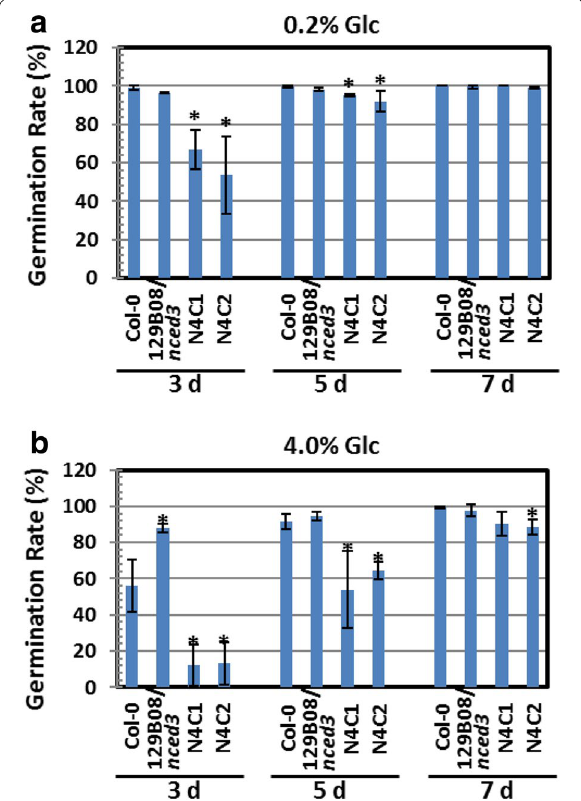
Fig. 3 Heterologous expression of OsNCED4 delayed seed ger‑ mination in Arabidopsis. a Germination rate of seeds from Col‑0, 129B08/ nced3 mutant, and two OsNCED4 ‑overexpressing transgenic lines grown on agar medium supplemented with 0.2% Glc for 3, 5, and 7 days. b Germination rate of the same transgenic lines grown on agar medium supplemented with 4% Glc for 3, 5, and 7 days. The values are the mean SD of three independent experiments, each ± with 80–100 seeds. * P < 0.05, Student’s t test